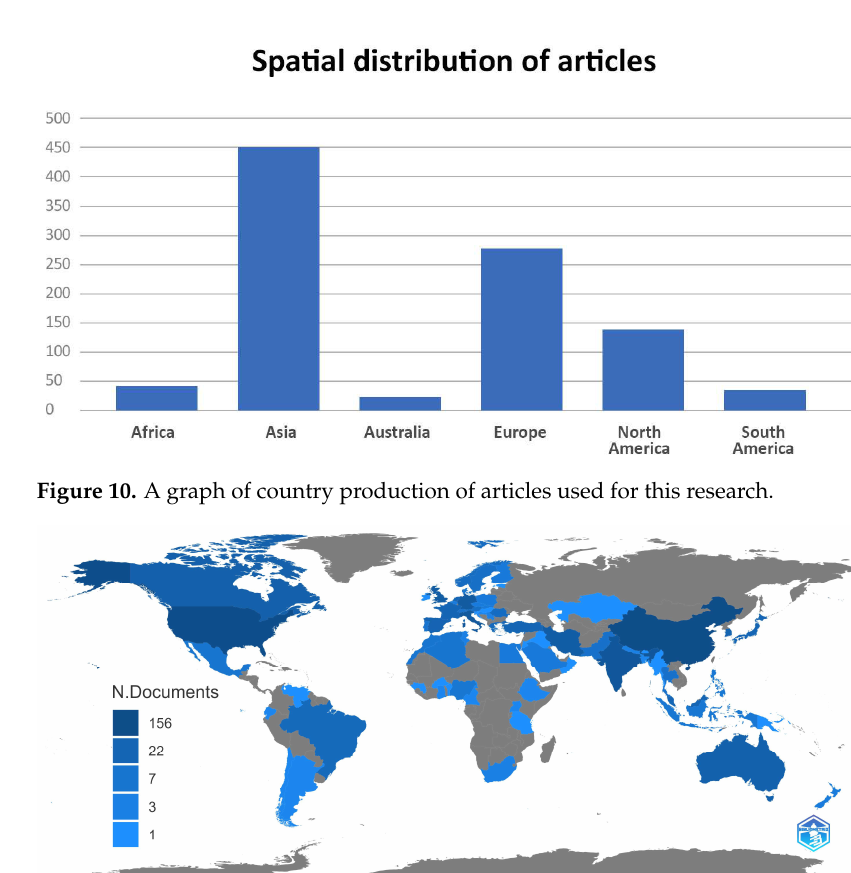
Figure 11. Spatial distribution of articles used for this research.